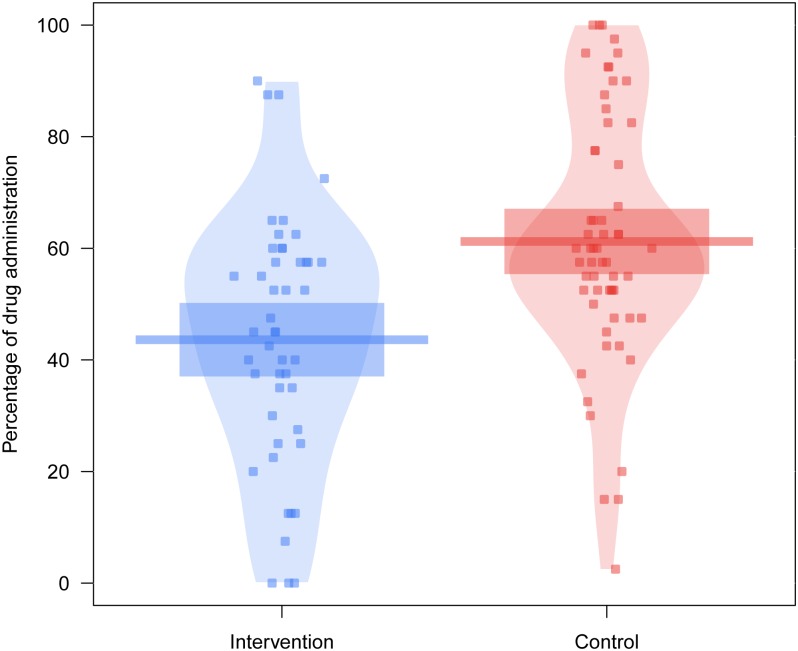
Percentages of drug administration.For each condition, the points represent the raw data, the horizontal lines represent the mean percentage of drug administration, and the rectangles the 95% confidence intervals.